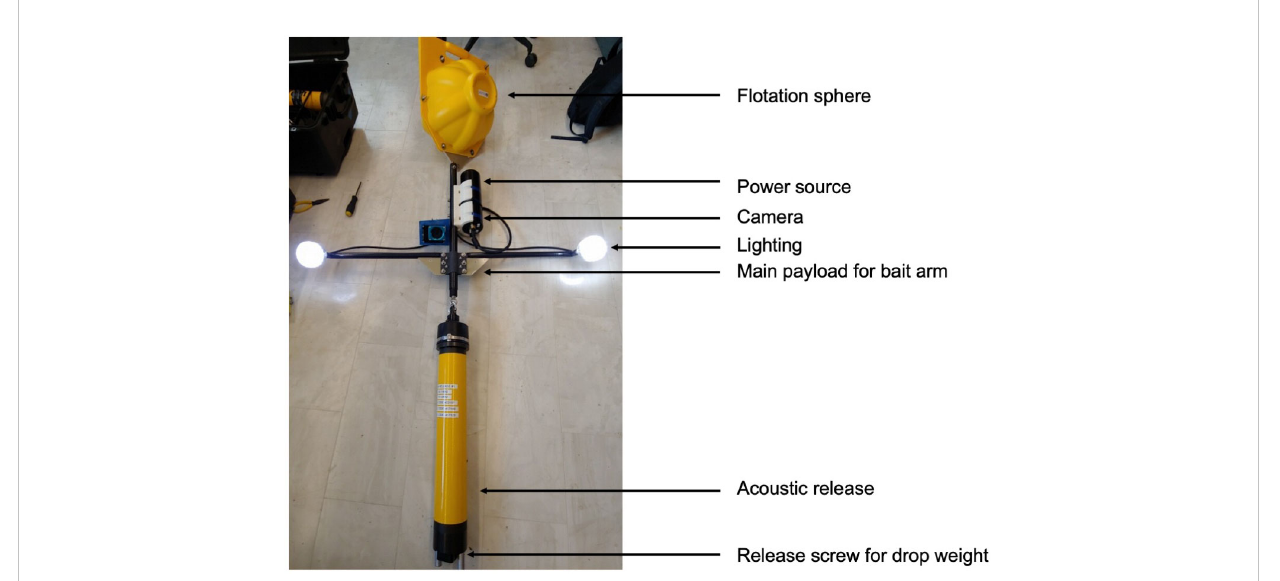
FIGURE 1 Diagram of the deep-sea BRUV (dBRUV) video camera/lander system used in the present study, with its associated